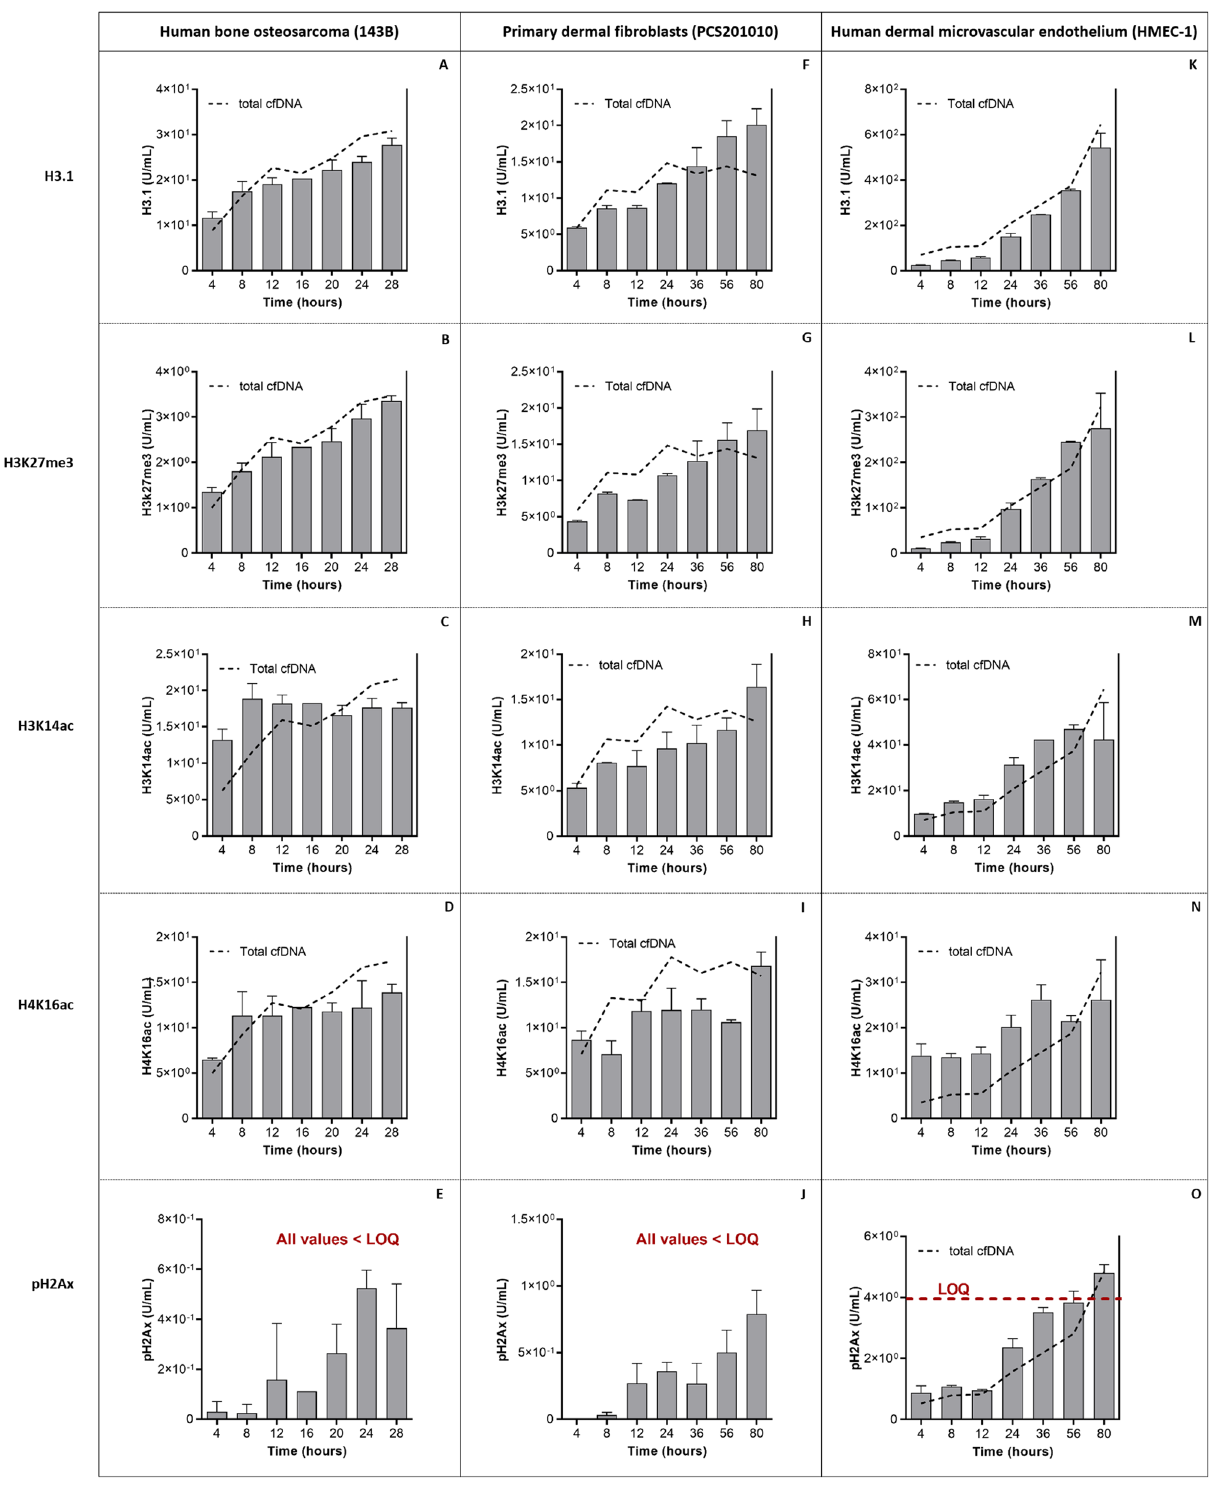
Figure 2. Longitudinal measurements of nucleosomal H3.1 and histone PTMs in three cell lines. Using chemiluminescence based Nu.Q Immunoassays, total levels of H3.1, H3K27me3, H3K14ac, H4K16ac and pH2AX, respectively, were measured directly from 50 µL of cell culture supernatant collected at different time-points after increasing periods of incubation from (A-E) human bone osteosarcoma (143B) cells, (F-J) primary dermal fibroblasts (PCS201010), and (K–O) human dermal microvascular endothelial cells (HMEC-1). For all cell lines, each time-point bar represents the mean of measurements from two biological replicates (i.e., parallel characterization of two separate cell culture flasks), except for the 16 h time-point in 143B cells, for which data from one of the flasks was compromised due to experimental error and omitted. Error bars indicate standard deviation. As indicated in red text in Figs E, J and O, all measured pH2AX values were under the limit of quantification (LOQ) of the assay, except for the 80 h time-point in HMEC-1 cells. The dotted black lines overlayed on each graph illustrate the corresponding pattern of total cfDNA levels, as measured by a qPCR assay (data from Fig.